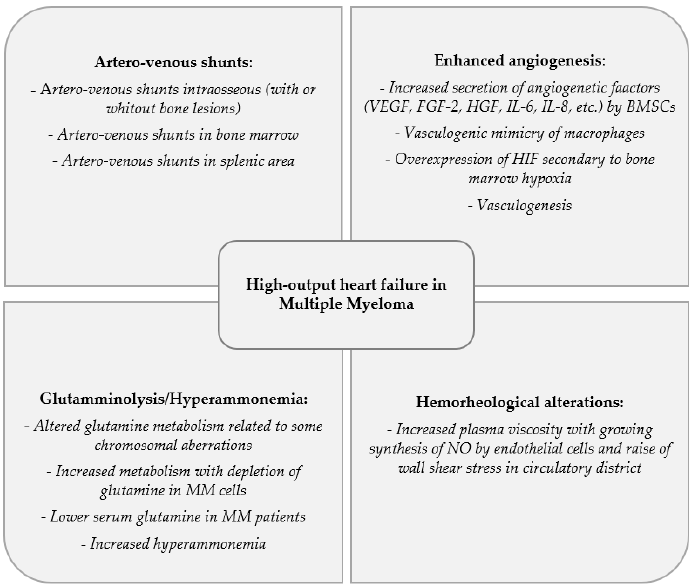
Figure 2. Factors linked to the high-output heart failure (HOHF) in Multiple